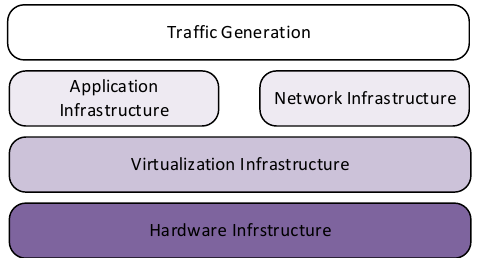
Figure 3. Logical representation of the deployed components.